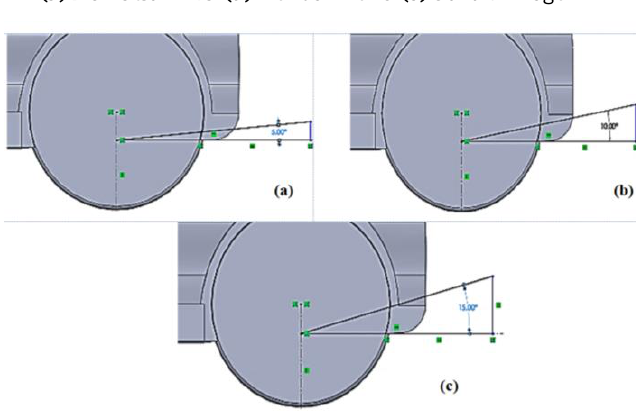
Fig. 19. Various diffuser angles on which analyses are performed for (a) 5 o (b) 10 o (c) 15